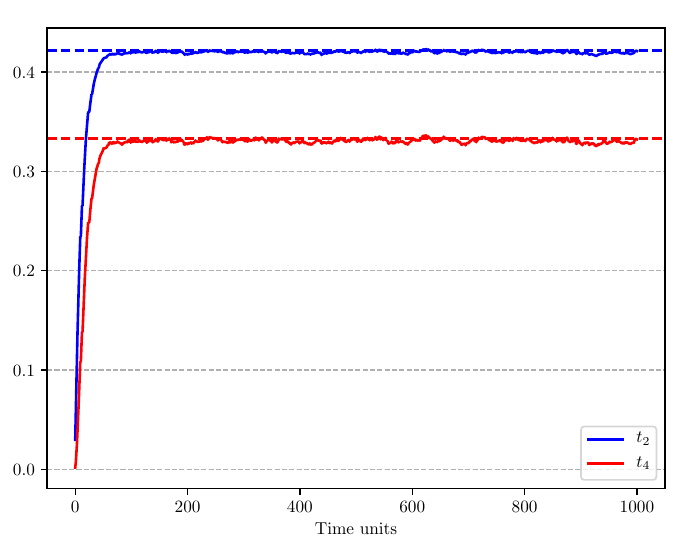
Figure 7: The matrix model defined by (42) is not solvable for generic g and h and was recently studied using bootstrap methods. We show the MC results by solid lines and those obtained using bootstrap by dashed lines. We get few digits of ac- curacy with 1000 time units by running for about 1.5 hours on a laptop. The re- sults shown are with g = h = 1 and N = 300. For larger N = 800, the same run will take about 16-18 hours. We did an extended run for about 80-85 hours ac- = 0.42179 ( 3 ) and t = 0.33336 ( 5 ) cumulating 5000 time units and obtained t 2 4 ≤ 0.421784687 and with N = 800. The bootstrap results are 0.421783612 ≤ t 2 ≤ 0.333342131 [ 22 ] . In fact, we can easily compute higher mo- 0.333341358 ≤ t 4 = 0.7153 ( 8 ) and t = 6.96 ( 8 ) . ments and we find that t 16 32 The action in (42) has (cid:90) ⊗ 3 symmetry (i.e., X → Y , X → − X , and Y → − Y ). For g = 2